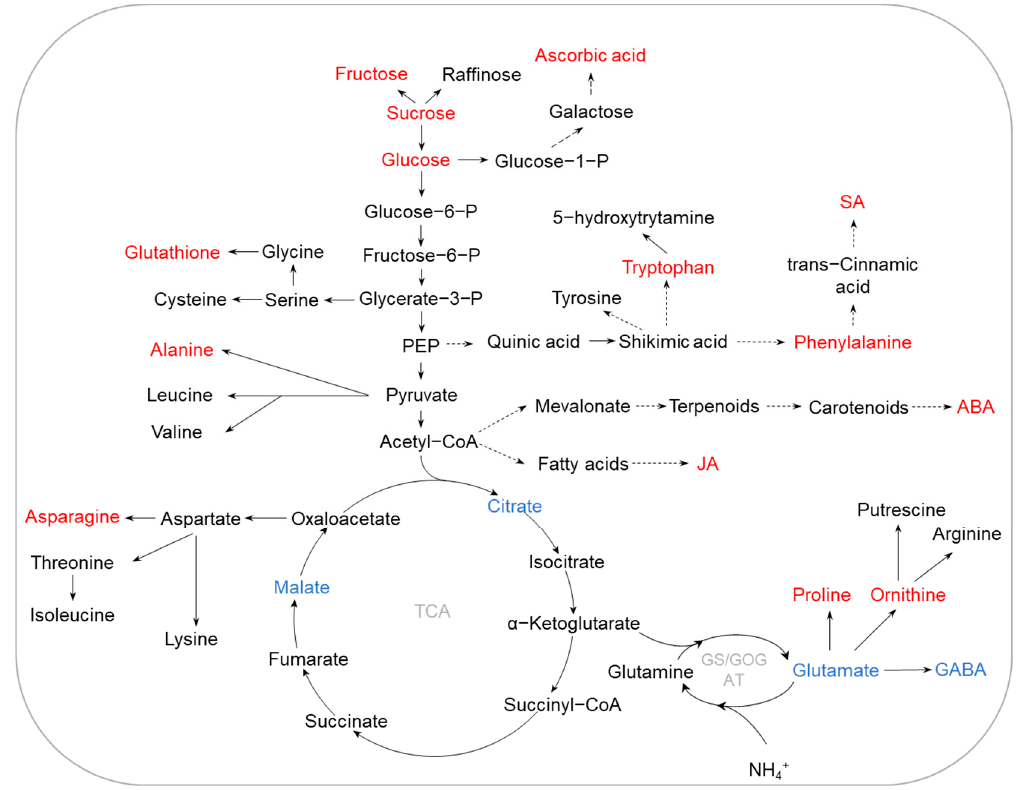
Figure 3. Metabolic pathways regulated by K deficiency in crops. K deficiency affects diverse pathways, including N metabolism, TCA cycle, glycolysis, shikimic acid pathway, and secondary metabolic pathways, accumulating stress-tolerant metabolites and phytohormones. The accumulated and reduced metabolites are marked in red and blue, respectively. Abbreviations: SA (salicylic acid), JA (jasmonic acid), ABA (abscisic acid), GABA ( γ -aminobutyric acid), TCA (tricarboxylic acid), GS/GOGAT (glutamine synthetase/glutamate synthetase).